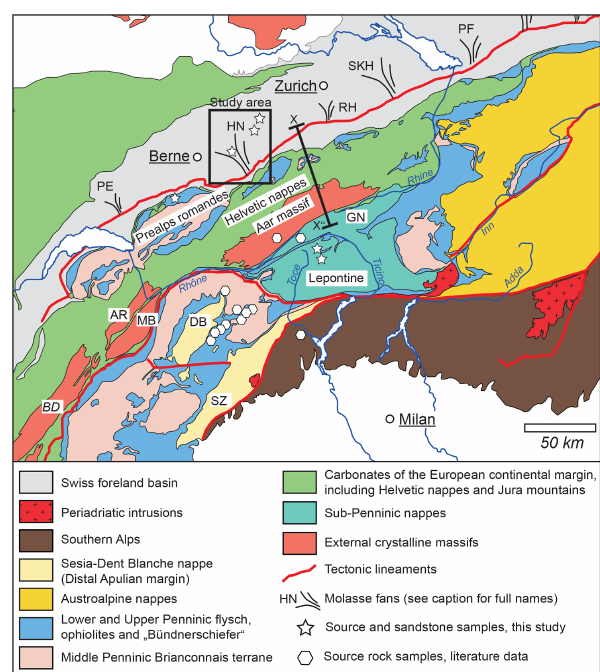
Figure 1. Simplified tectonic map of the Central Alps after Schmid et al. (2004) highlighting the location of alluvial fan deposits within the northern Alpine foreland basin as well as the most important source rock units in the hinterland. The Honegg–Napf fan, marked by the black rectangle, is located in the central part of the Swiss foreland basin (SFB). For cross section X–X (cid:48)(cid:48) see Fig. 7.